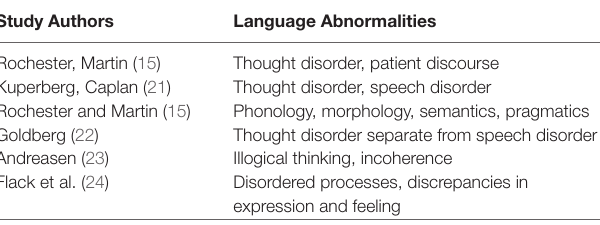
TABLE 1 | Table of language abnormalities.